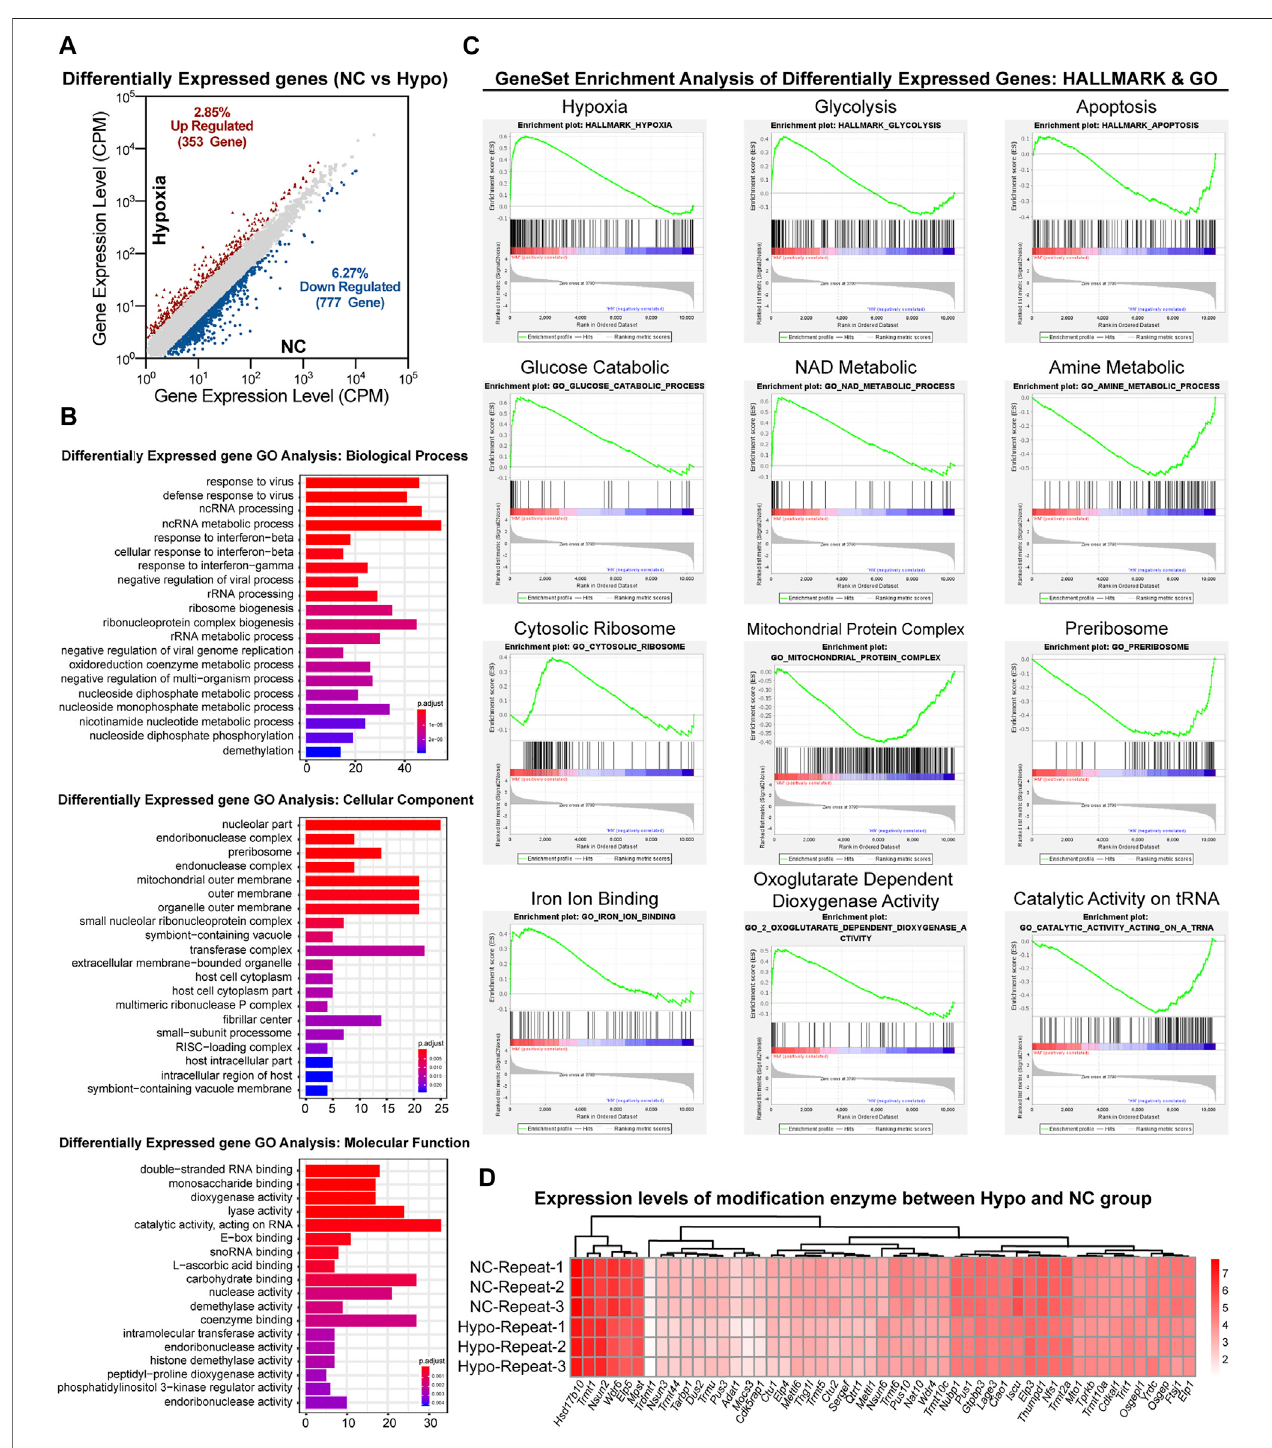
FIGURE4| TranscriptomicanalysisofgeneexpressioninGC-2spdcellssubjectedtohypoxicstress. (A) DifferentiallyexpressedgenesbetweentheHypoandNC groups. (B) GOanalysisofdifferentiallyexpressedgenesbetweentheHypoandNCgroups.Thedifferentiallyexpressedgeneswereenrichedinthekeywords “ biological process, ”“ cellular component, ” and “ molecular function. ” The x -axisrepresentsthenumber ofgenes,and the colorindicatesthe p -value (blueindicates alarge p -value, and red indicates a small p -value). (C) GSEA analysis of differentially expressed genes in GC-2spd cells subjected to hypoxic stress in the GO and hallmark gene sets, respectively, ranked based on normalized p -value. (D) Heat map diagram showing the expression levels of modi fi ed enzymes in the Hypo and NC groups. Colors ranging from white to red indicate mRNA expression levels; the red color indicates high expression levels, while the white color indicates low expression levels.